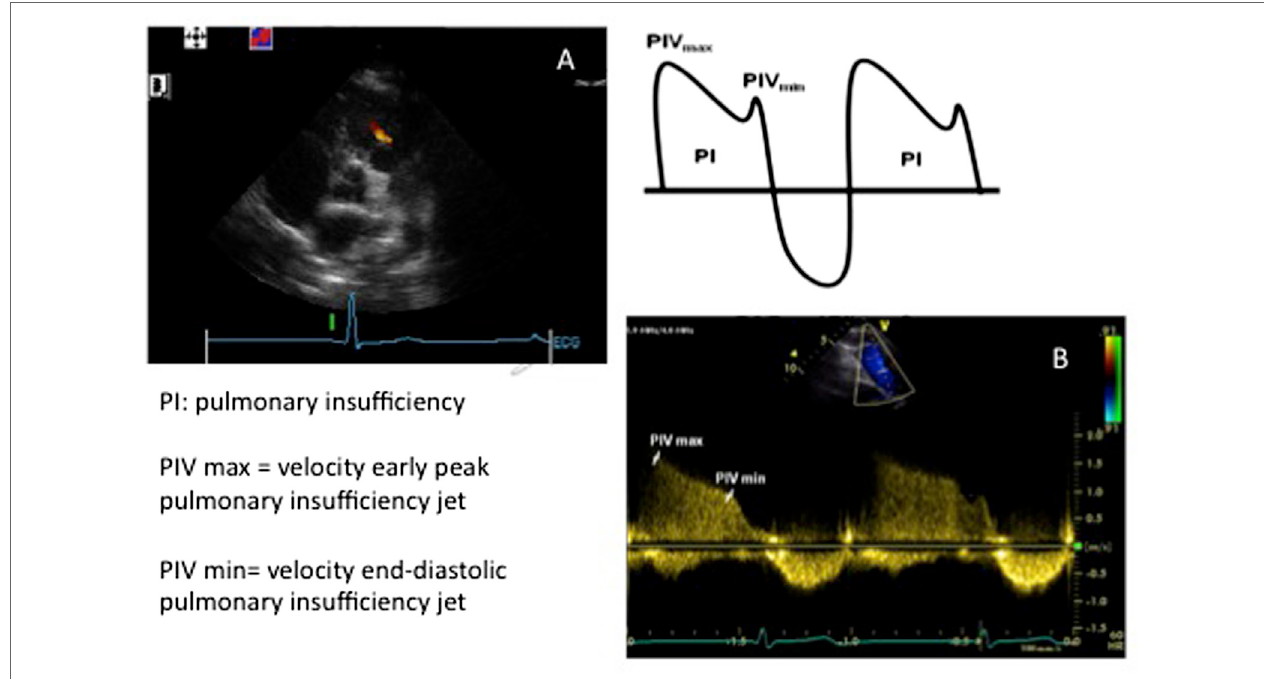
FigURe 2 | Images showing (A) short axis view and a pulmonary insufficiency jet and (b) Doppler envelope of the pulmonary insufficiency jet allowing for measurement of the peak velocity of the pulmonary insufficiency jet (PIV max ) and the peak velocity of the end diastolic pulmonary insufficiency jet (PIV min ). See the text for